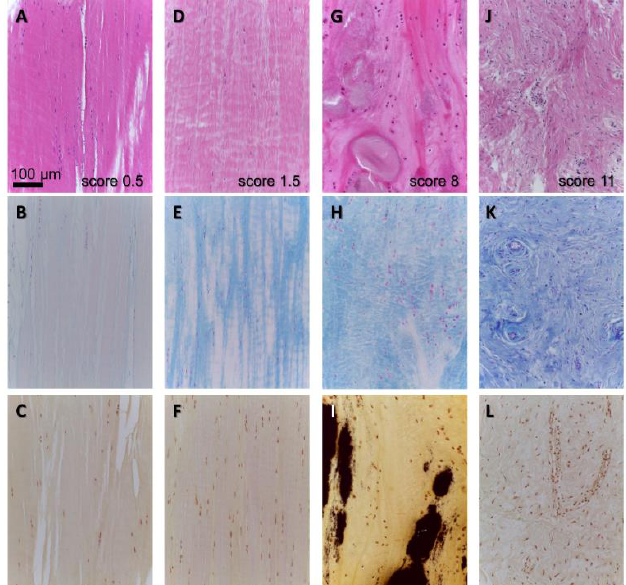
Figure 4. Histopathological features of human ACL degeneration in OA. ( A , D , G , J ): HE staining to give an overview over tissue organization. ( B , E , H , K ): Alcian blue staining to visualize distribution of sulfated glycosaminoglycans (blue), ( C , F , I , L ): van Kossa staining to detect calcium deposits (black). The scoring results with the scoring system used by [11] are depicted in ( A , D , G , J ), ( A – C ): nearly unchanged, ( G – I ): chondroid metaplasia and focal calcification, ( J – L ): ECM disintegration, hypercellularity, hypervascularization.